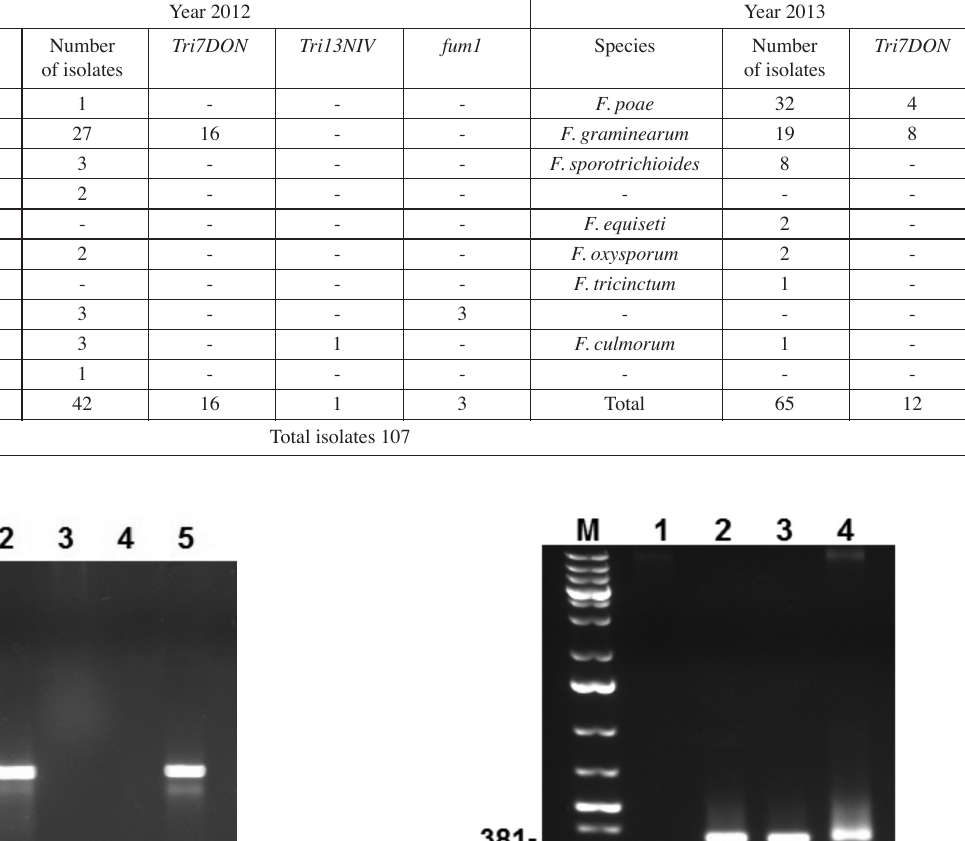
Tab. 2: Species composition, prevalence of each Fusarium species isolated from ears of winter wheat and the occurrence of the examined mycotoxin pro- duction genes No.